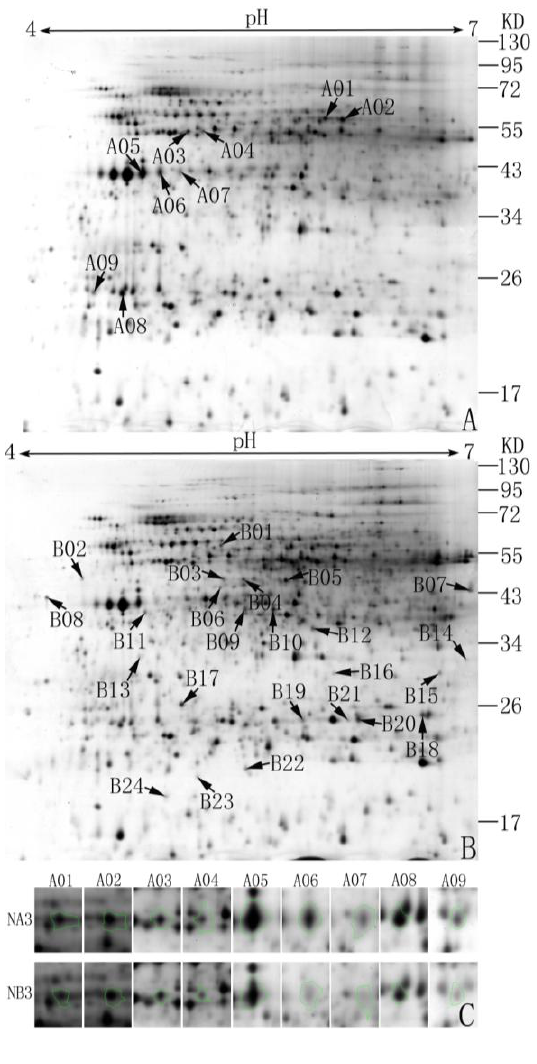
Figure 1. Two-dimension electrophoresis gels of anther/bud proteins in CMS NA3 line ( A ) and its maintainer NB3 line ( B ); some of the areas in NA3 and NB3 gels with differential spots have been enlarged below ( C ). Proteins were visualized by silver nitrate staining. The arrowed and numbered spots in the image were differentially expressed proteins. Molecular markers (kDa) are shown on the right. These results were repeated for three times.